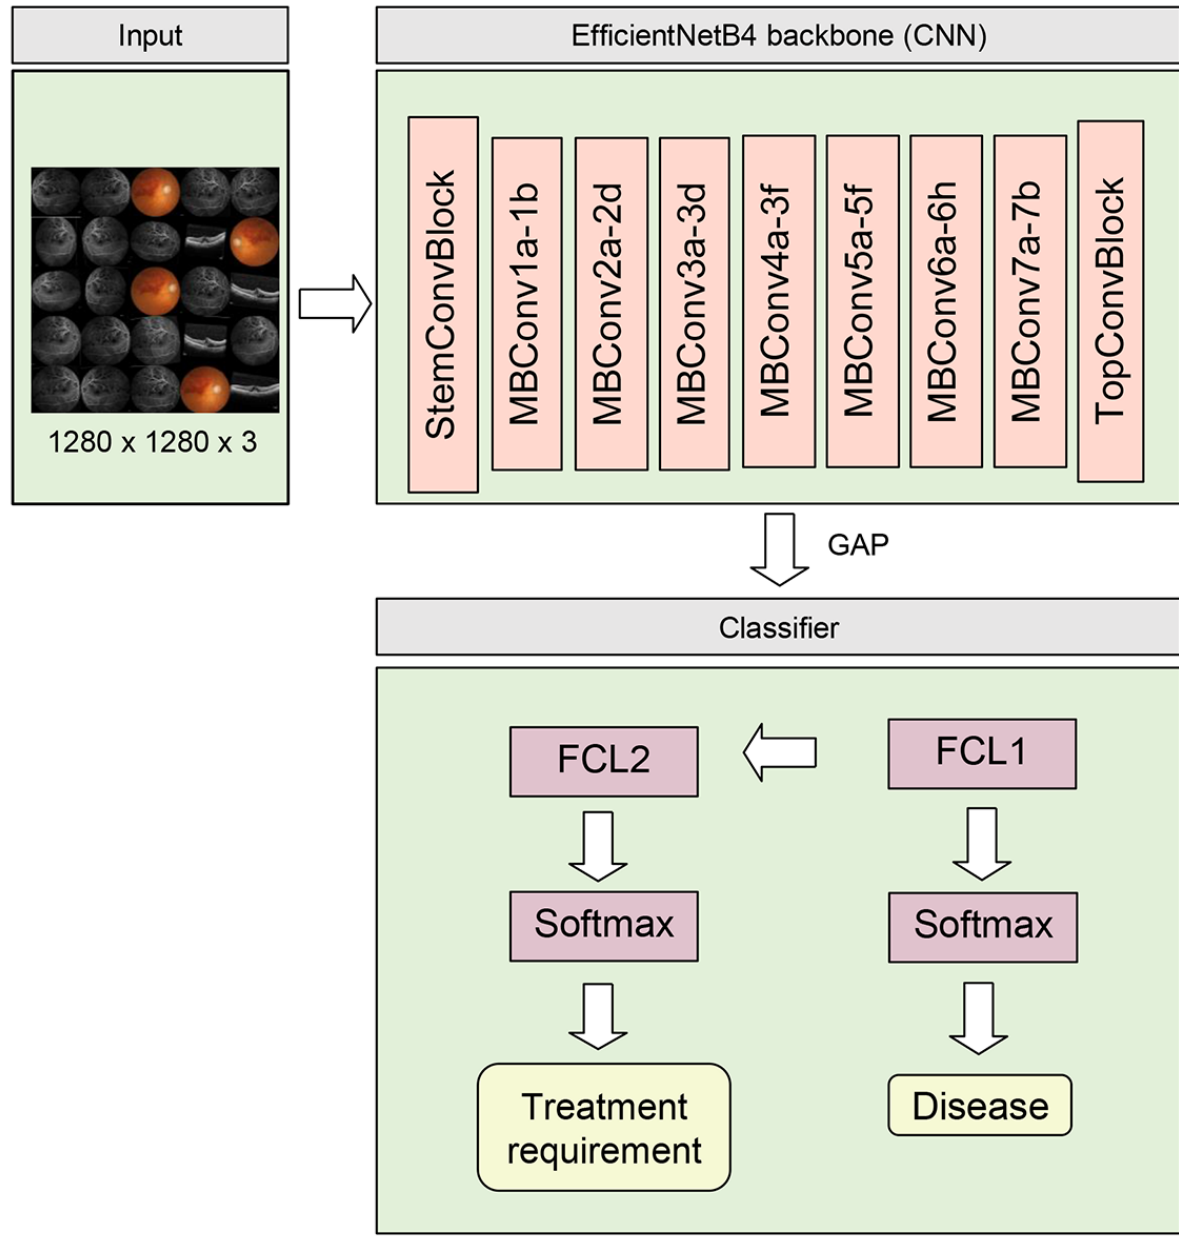
Figure 2. Architecture of the deep learning prediction model. CNN: convolutional neural network; FCL: fully connected layer; GAP: global average